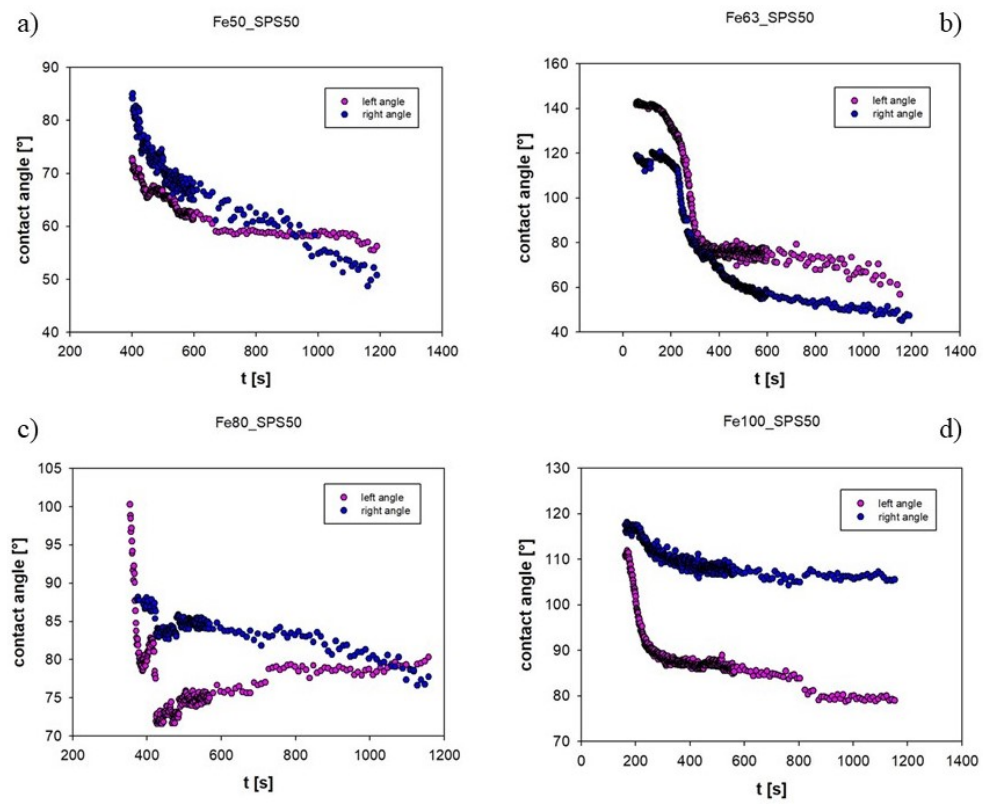
Figure 7. Trend of the contact angle as a function of time of pure Sn on ( a ) Fe50_SPS, ( b ) Fe630_SPS, ( c ) Fe80_SPS, and ( d ) Fe100_SPS. Table 3. Summary of the contact angles measured for pure Sn on